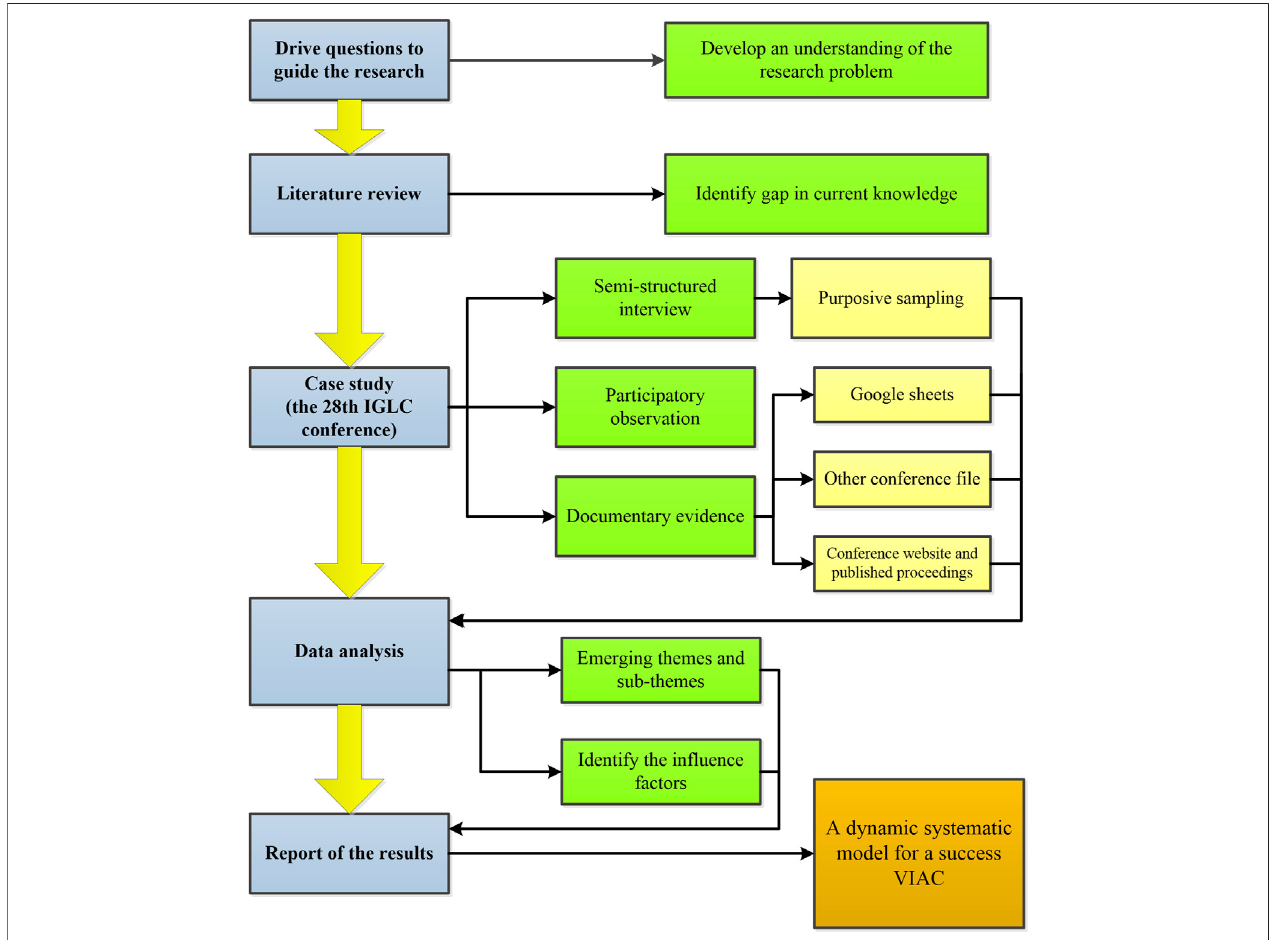
FIGURE 1 | Conceptual representation of the research design.